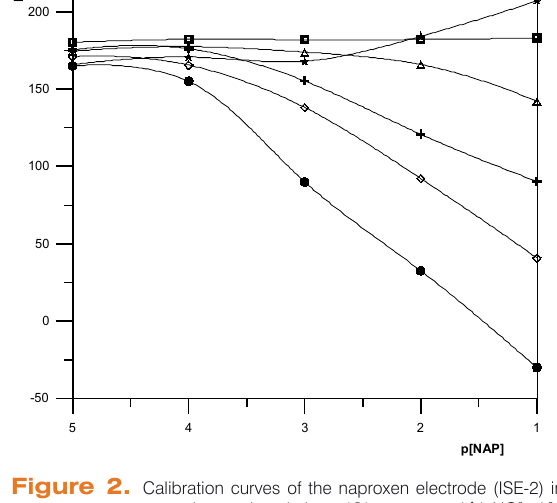
Figure 2. Calibration curves of the naproxen electrode (ISE-2) in water inorganic solution: (  ) naproxen, (  ) NO 3- , (  ) Figure 3. Calibration curves of the naproxen electrode (ISE 2) in Br - , (  ) Cl - , (  ) SO 42- , (  ) H PO 4- . water organic solution: (  ) naproxen, (  ) benzoate, (  ) 2 oxalate, (  ) acetate, (  ) citrate.